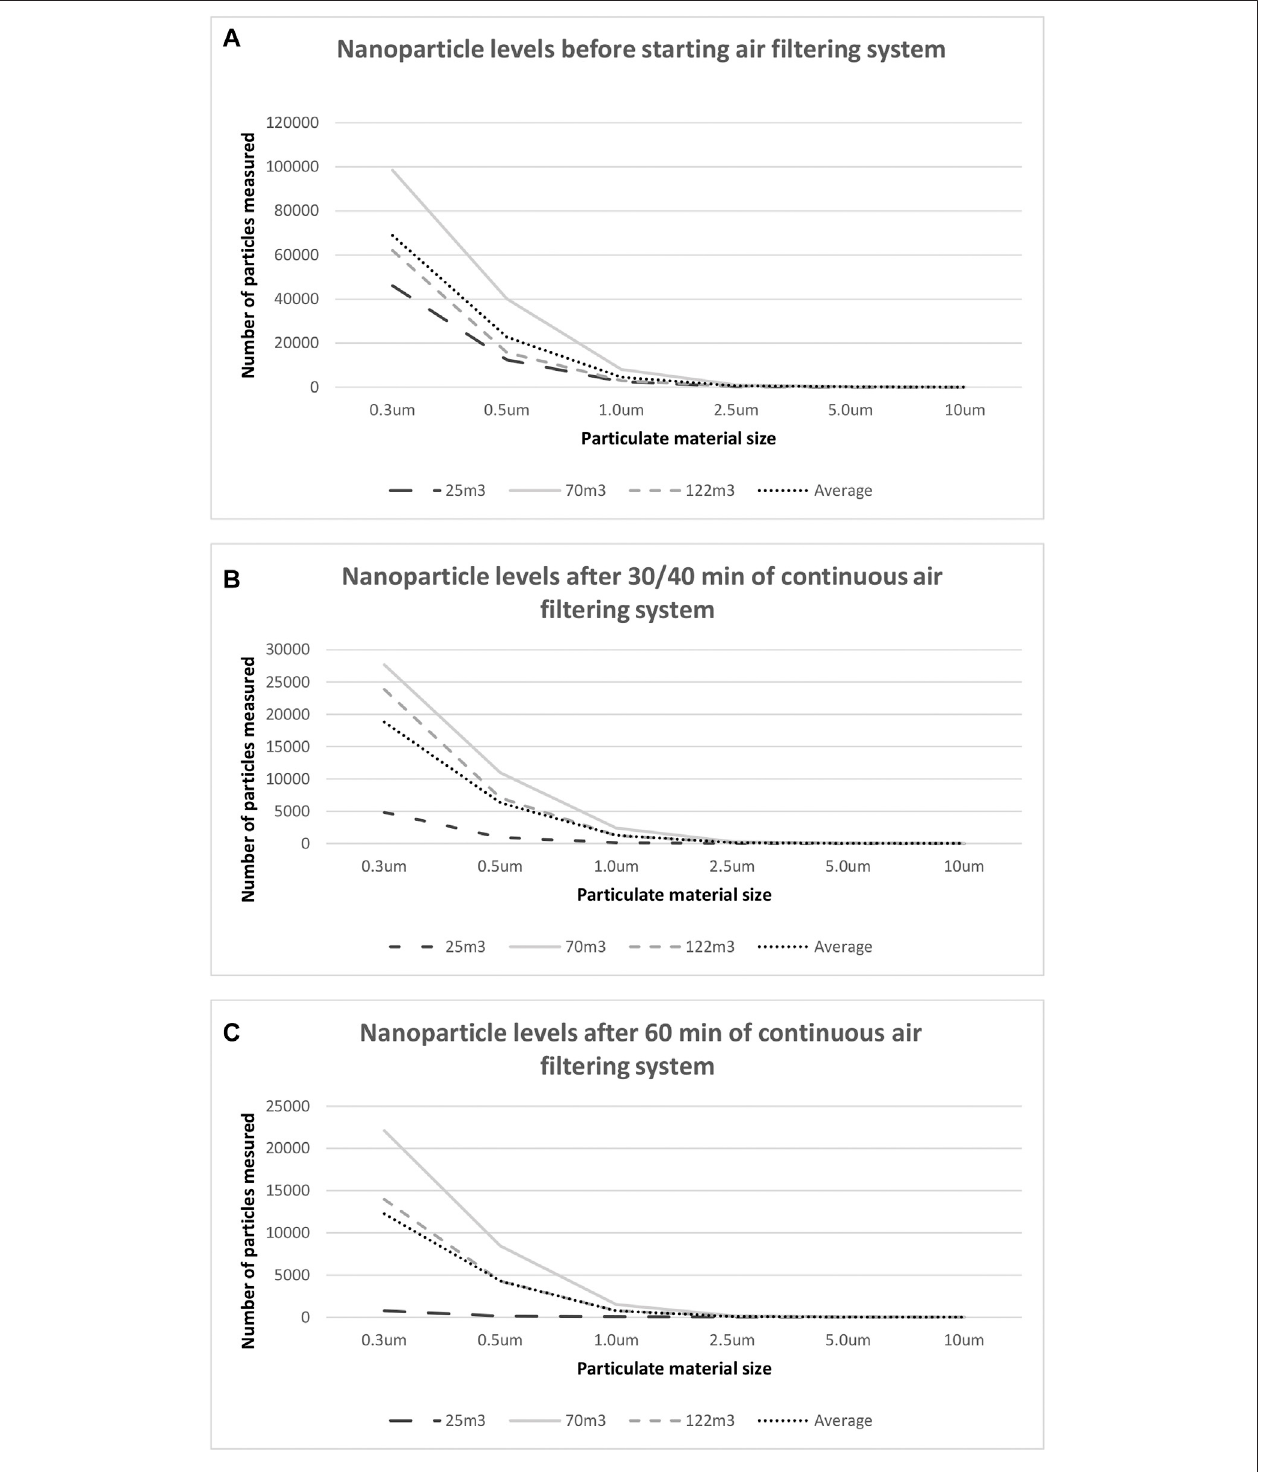
FIGURE 1 | Nanoparticle levels before starting air fi ltering system and after 30/40/60 min of continuous use air fi ltering system. Results from the detection test for particulate matter (PM) with different sizes (0.3, 0.5, 1.0, 2.5, 5.0, and 10 um) in the air present in several indoor 215 spaces; 25 m 3 (dotted thick), 70 m 3 (dashed thick), 122 m 3 (dotted thin) and the average value (dashed thin). Total number of particles was measured at a rate of 2.83 L per minute and every 217 21 s, with intervals of 0.99 L. (A) before air fi ltering system; (B) after 30/40 min and 218 (C) after 60 min of continuous air fi ltering system.